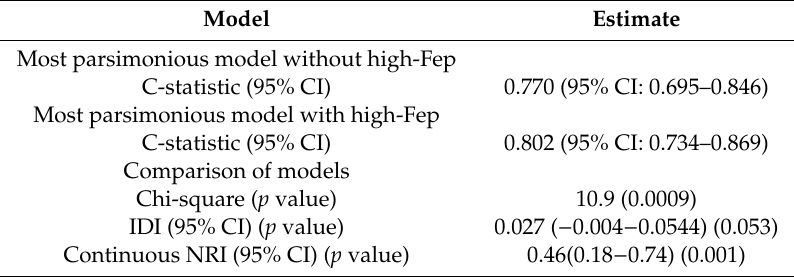
Table 6. Model discrimination with and without FeP to predict CKD